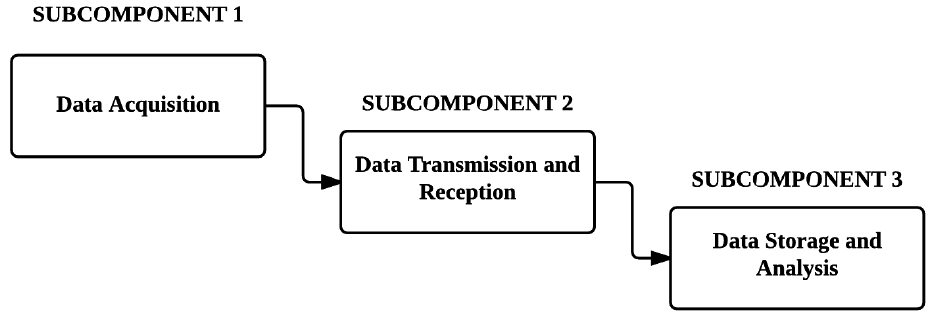
Figure 1. General overview of the desired system.